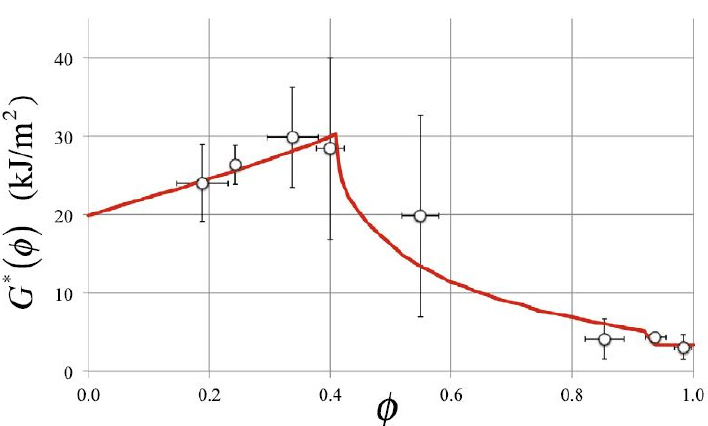
F igure 26. Effect of mode mixicity ratio on single z-Pin apparent fracture toughness (CFRP z-Pin, 2.0 vol%, d = 0.28 mm, quasi-isotropic pre-preg) [12].